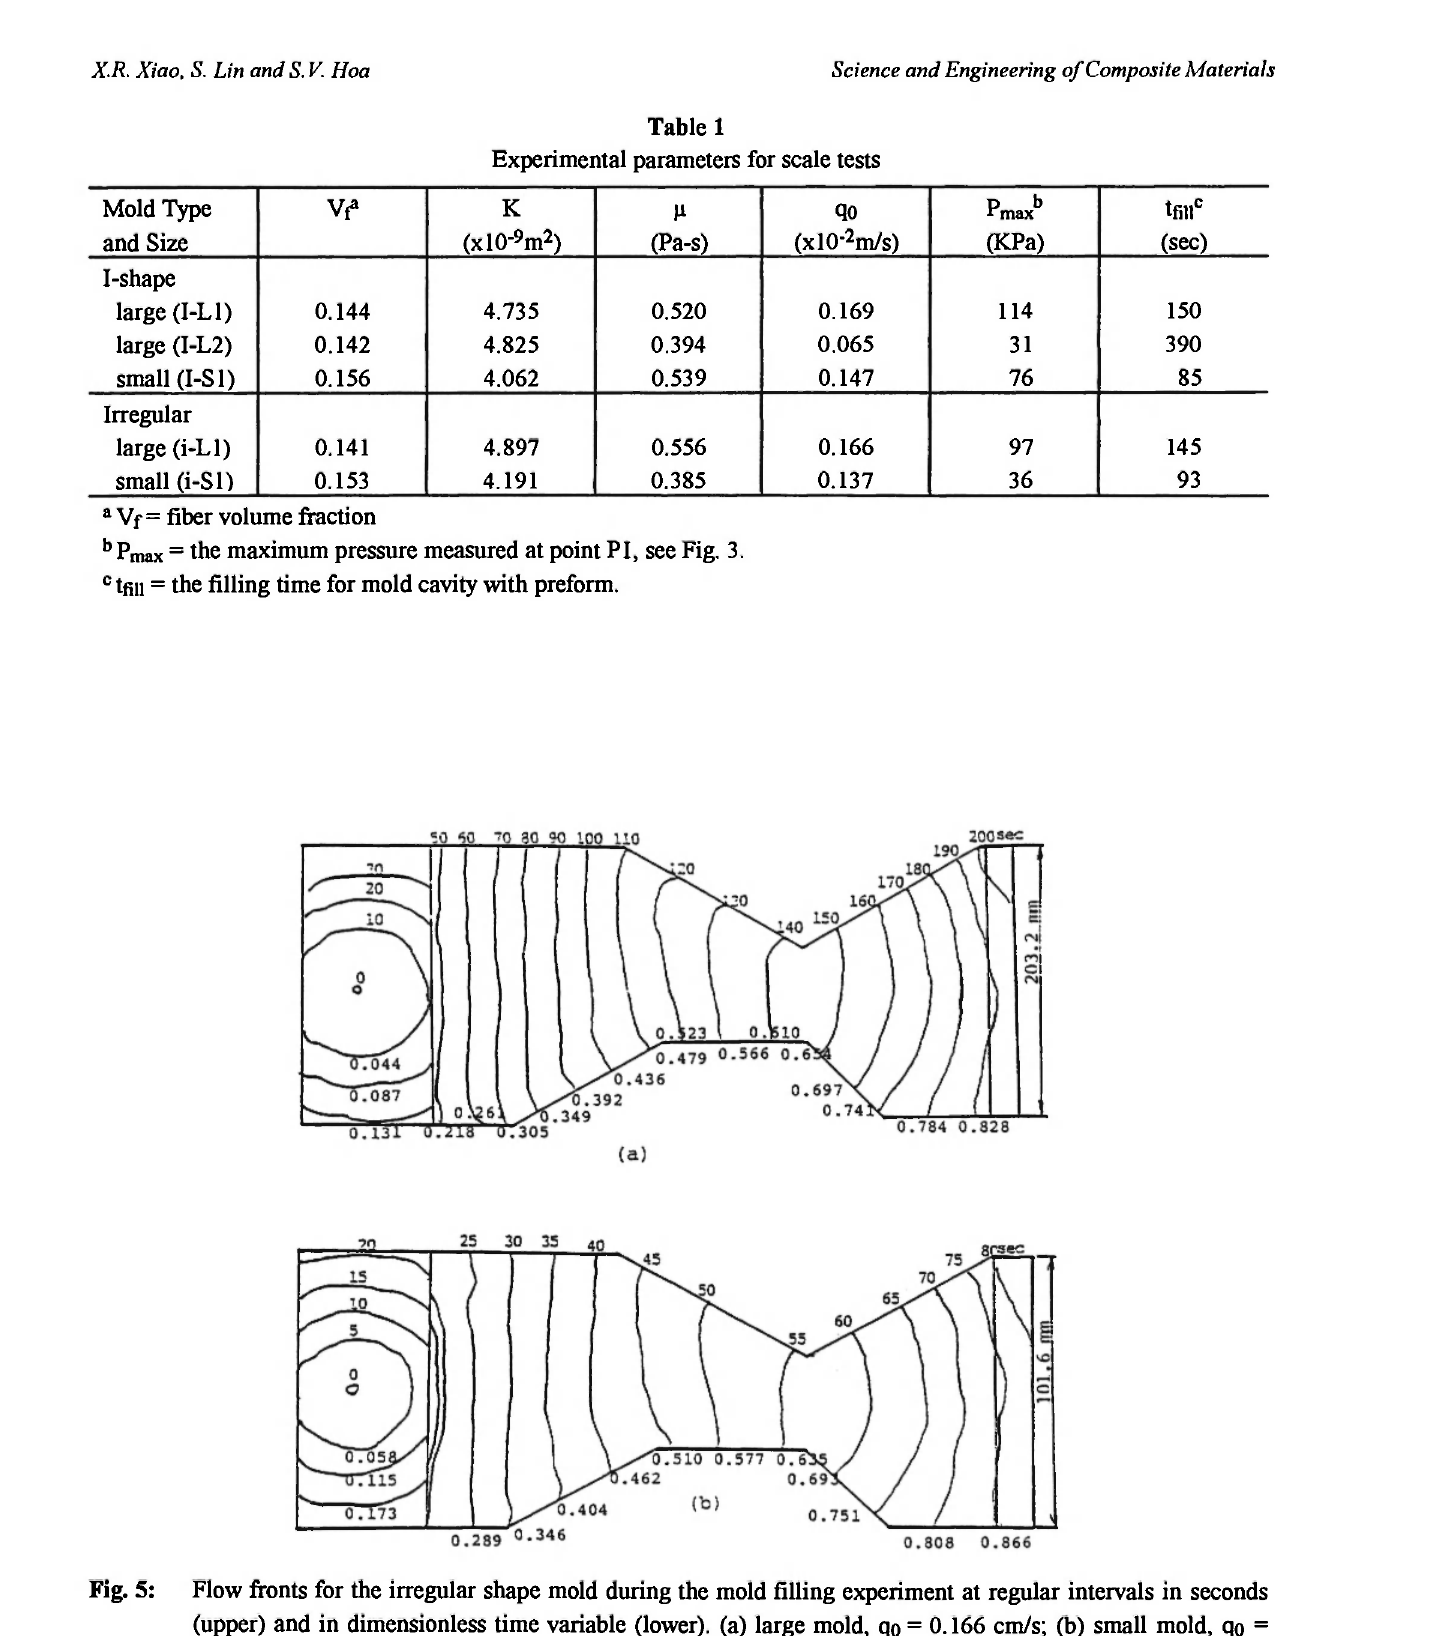
Fig. 5: Flow fronts for the irregular shape mold during the mold filling experiment at regular intervals in seconds (upper) and in dimensionless time variable (lower), (a) large mold, qo = 0.166 cm/s; (b) small mold, qo = 0.220